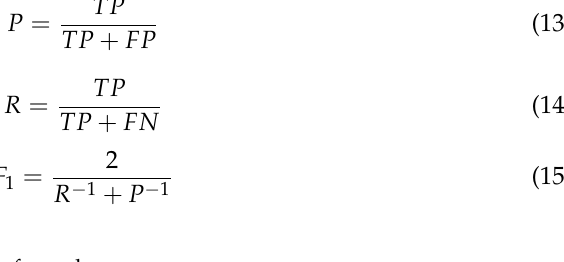
Table 2. The relevant information in these formulas.